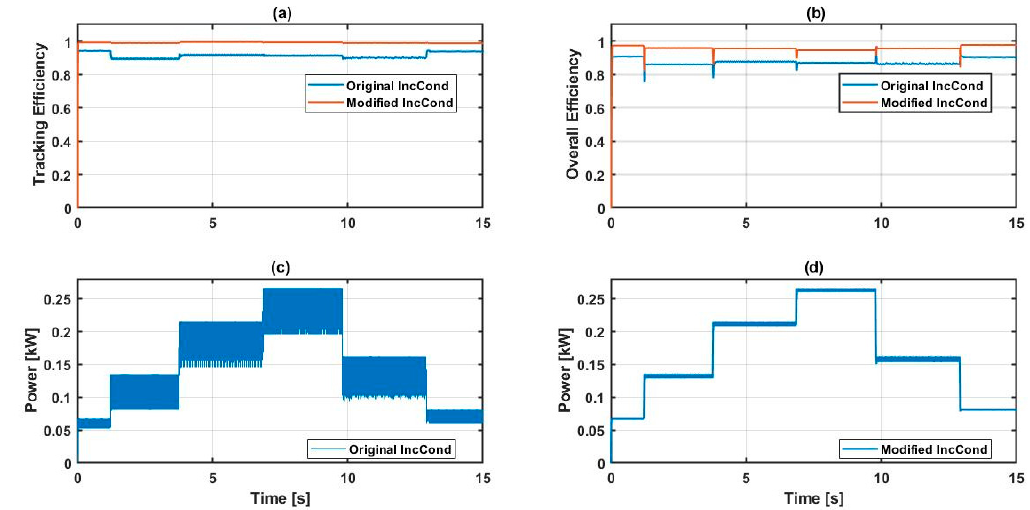
Figure 10. Low-power PV system with comparison of ( a ) tracking efficiency; ( b ) overall system efficiency; ( c ) original IncCond PV output power; and ( d ) modified IncCond PV output power.